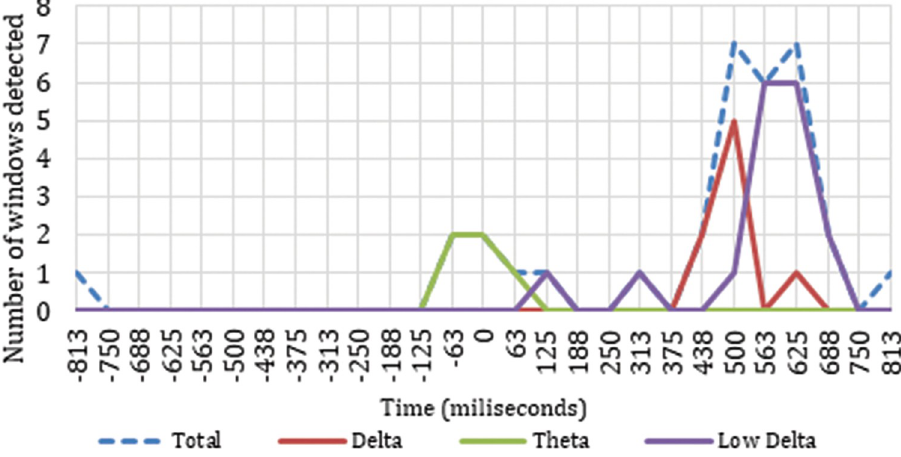
Fig 8. Distribution of time windows that have variations with monotonous and significant slopes in the power change as a response to the cut event.